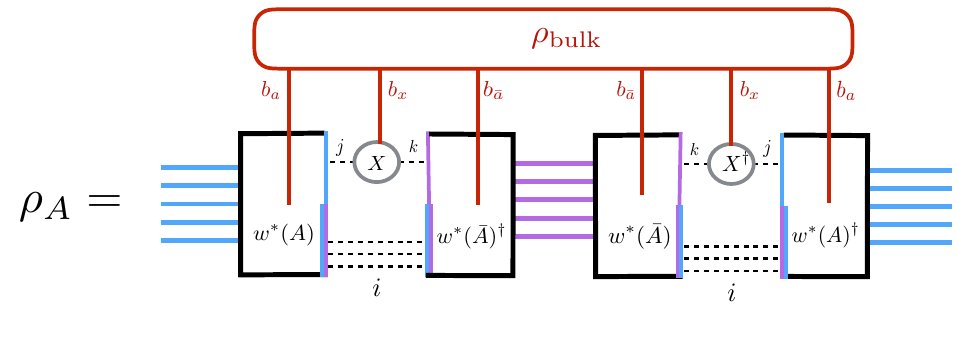
Figure 7. The reduced density matrix (cid:26) into pieces corresponding to w (cid:3) ( A ), w (cid:3) ( (cid:22) A ), and X . The j links describe network edges cut by (cid:13) (cid:3) the k links describe network edges cut by (cid:13) (cid:3)